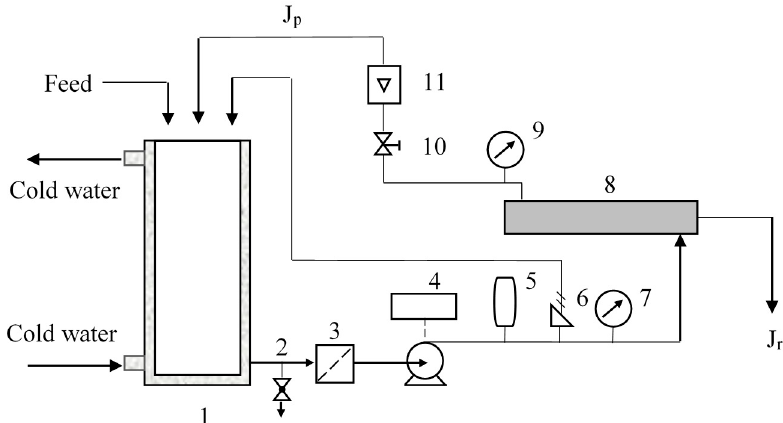
Figure 3. Separation device of the nanofiltration. 1. Circulating tank; 2. Drain valve; 3. Pipeline filter; 4. Pump; 5. Frequency converter; 6. Safety relief valve; 7. Pressure gauge; 8. Membrane unit; 9. Pressure gauge; 10. Pressure regulating valve; 11. Concentrate flow meter.